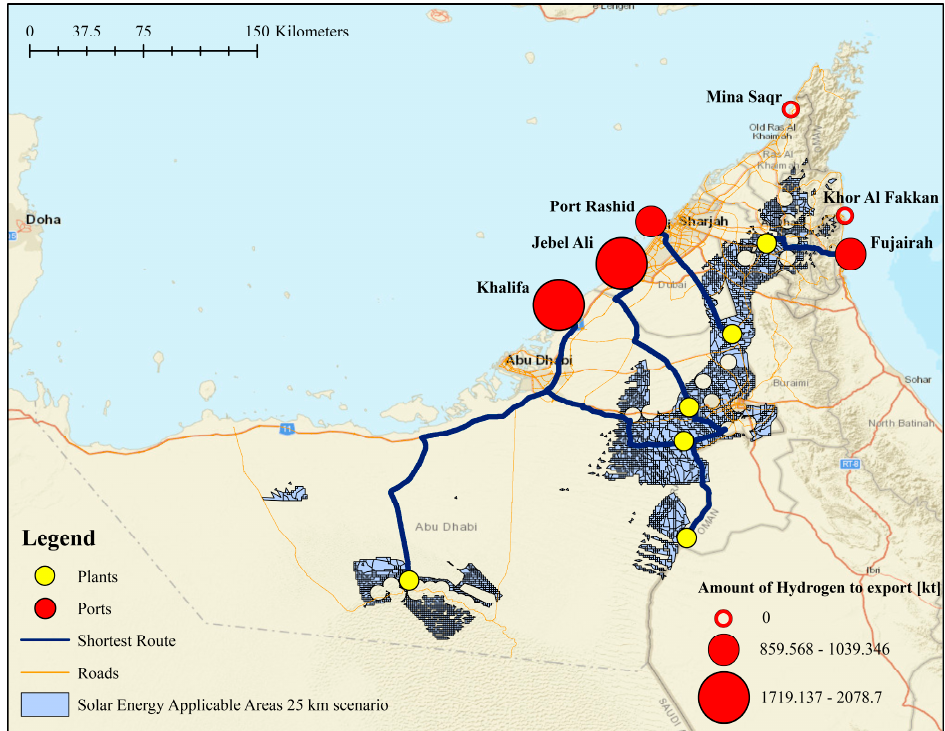
Figure 6. First pathway GIS analysis results for closest ports and shortest routes. Table 6. Amount of H 2 reaching each port in the first pathway from PV and CSP in (kg × 10 6